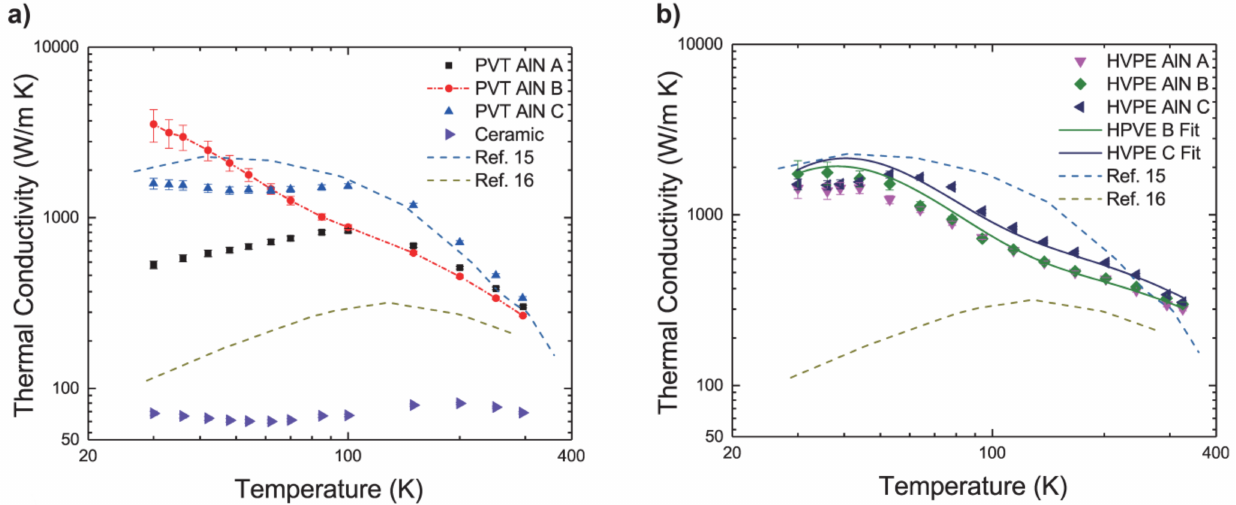
Figure 25. Temperature-dependent (30–325 K) thermal conductivities of ( a ) PVT and ( b ) HVPE bulk AlN with different impurity concentrations. Reprinted from [112], with the permission of AIP